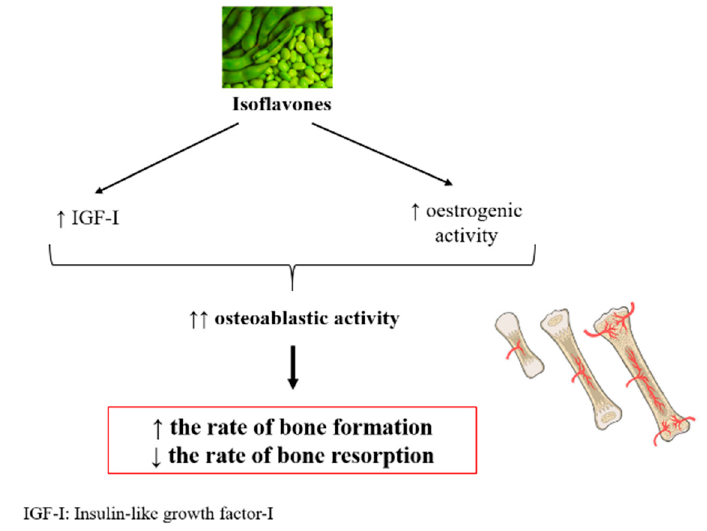
Figure 4. Potential mechanism of action of isoflavones on bone metabolism.